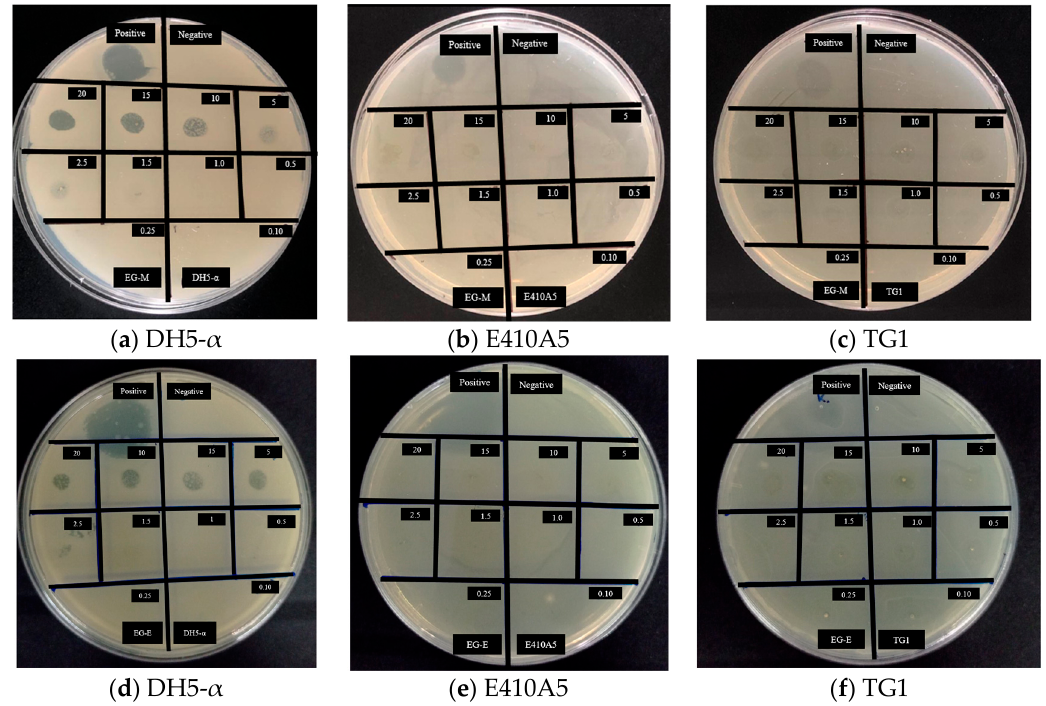
Figure 4. Antibacterial activity on E. coli strains by EG − methanolic and EG − ethanolic plant extracts. ( a–c ) are related to EG − methanolic extract, and ( d–f ) are EG − ethanolic extract.